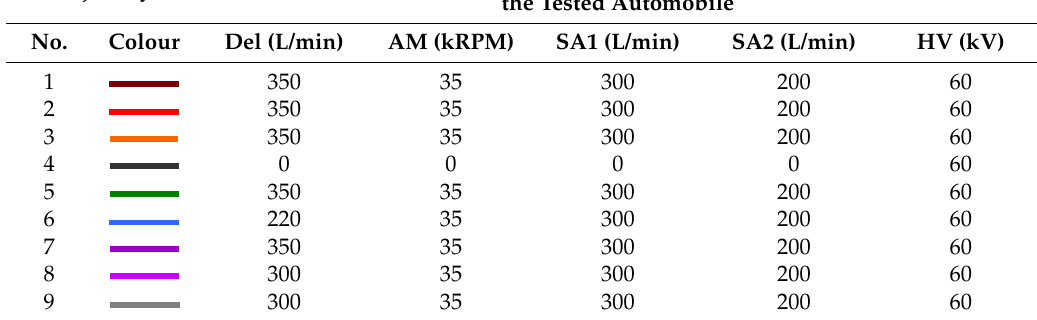
Table 3. Operating parameters of spray trajectory on the rear. Table 6. Operating parameters of the spray trajectory on the right and right ‐ rear parts of the tested automobile.